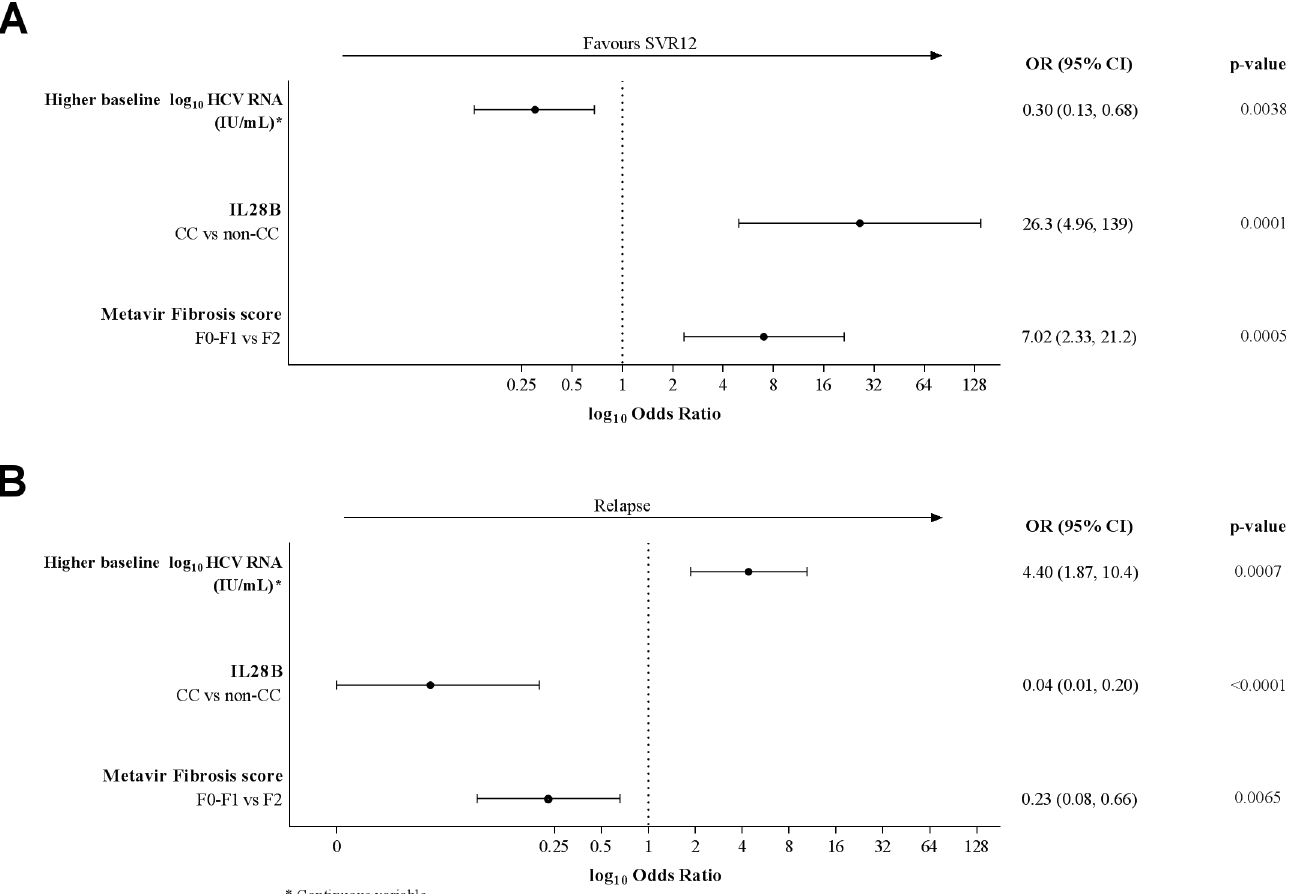
Fig 4. Forest plot showing the results of the final multivariate logistic regression analyses of factors associated with [A] SVR12 and [B] viral relapse in patients receiving 12 weeks of treatment.